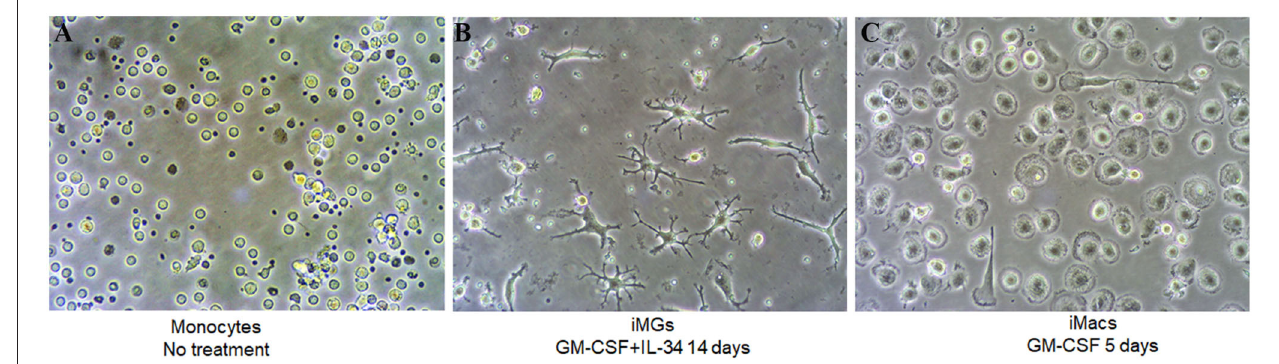
FIGURE 1 | iMG cells and iMacs were induced from human peripheral blood monocytes. Human peripheral blood monocytes were isolated from blood and stimulated with IL-34 and GM-CSF for microglia-like cells and GM-CSF only for macrophages. Representative images (A) monocytes after adherence without any treatment, (B) iMG cells on day 14 after monocytes treated with GM-CSF and IL-34, and (C) iMacs on day 5 after monocytes treated with GM-CSF.